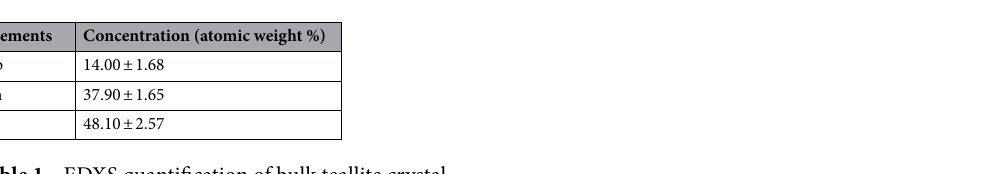
Table 1. EDXS quantification of bulk teallite crystal.